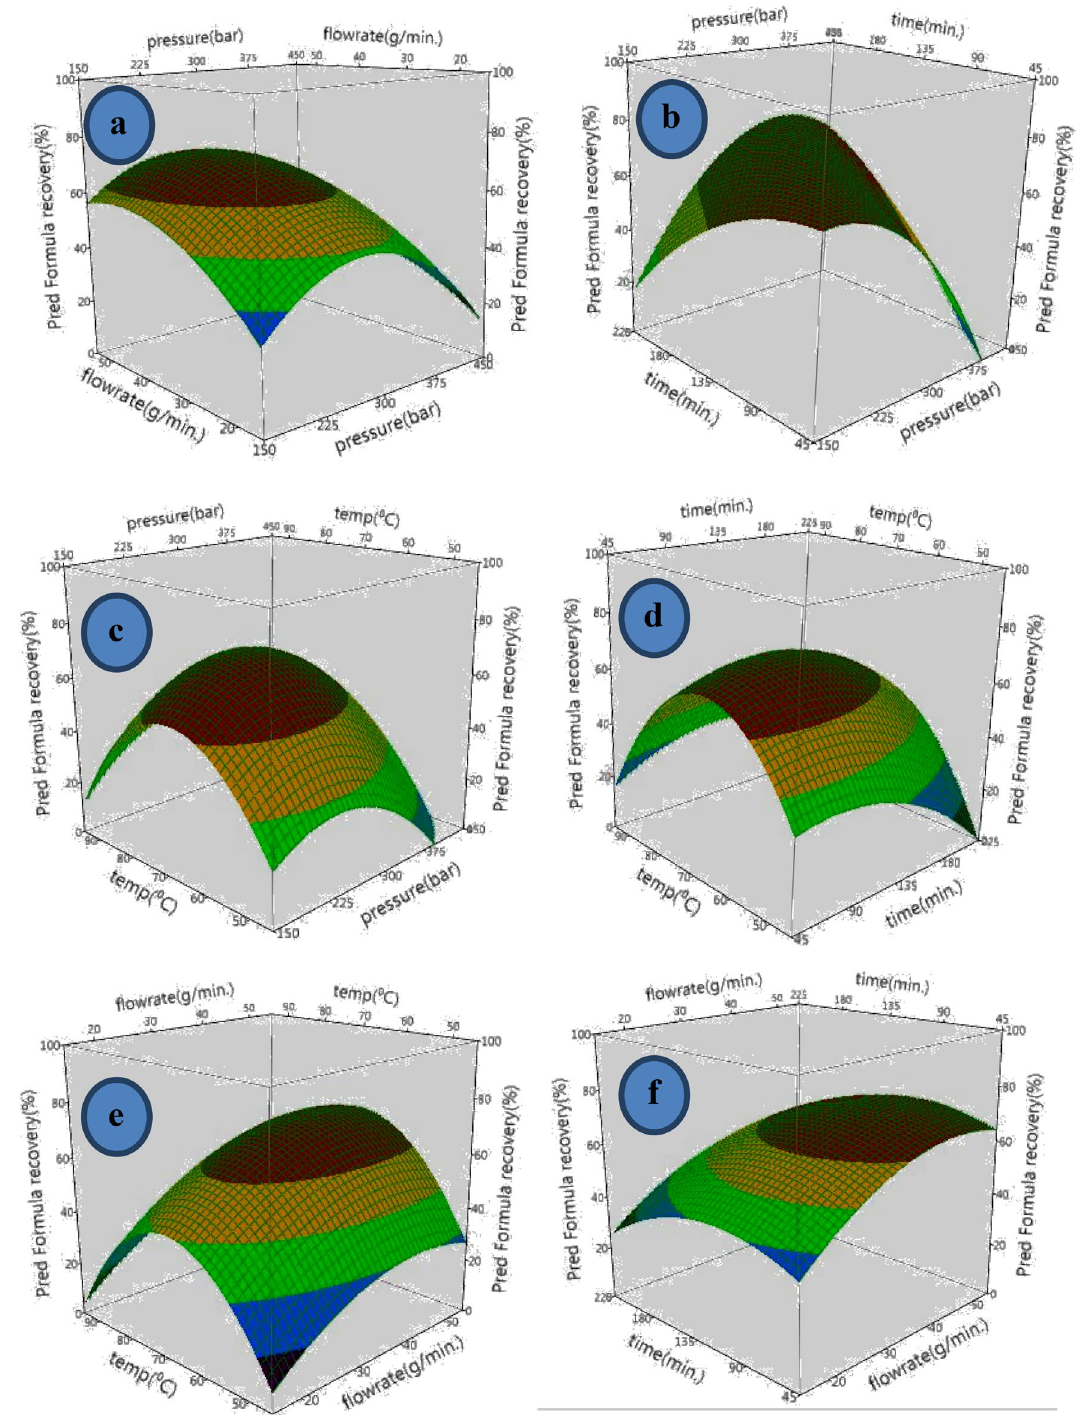
Figure 3. Response surface plot showing effects of two independent variables on lycopene yield from grapefruit while the remaining were kept at the central point (Pressure—300 bar; Flow rate—35 g/min; Time—135 min; and Temperature—70 °C). [SAS (r) Proprietary Software 9.4 (TS1M1), Copyright (c) 2002–2012 by SAS Institute Inc., Cary, NC,